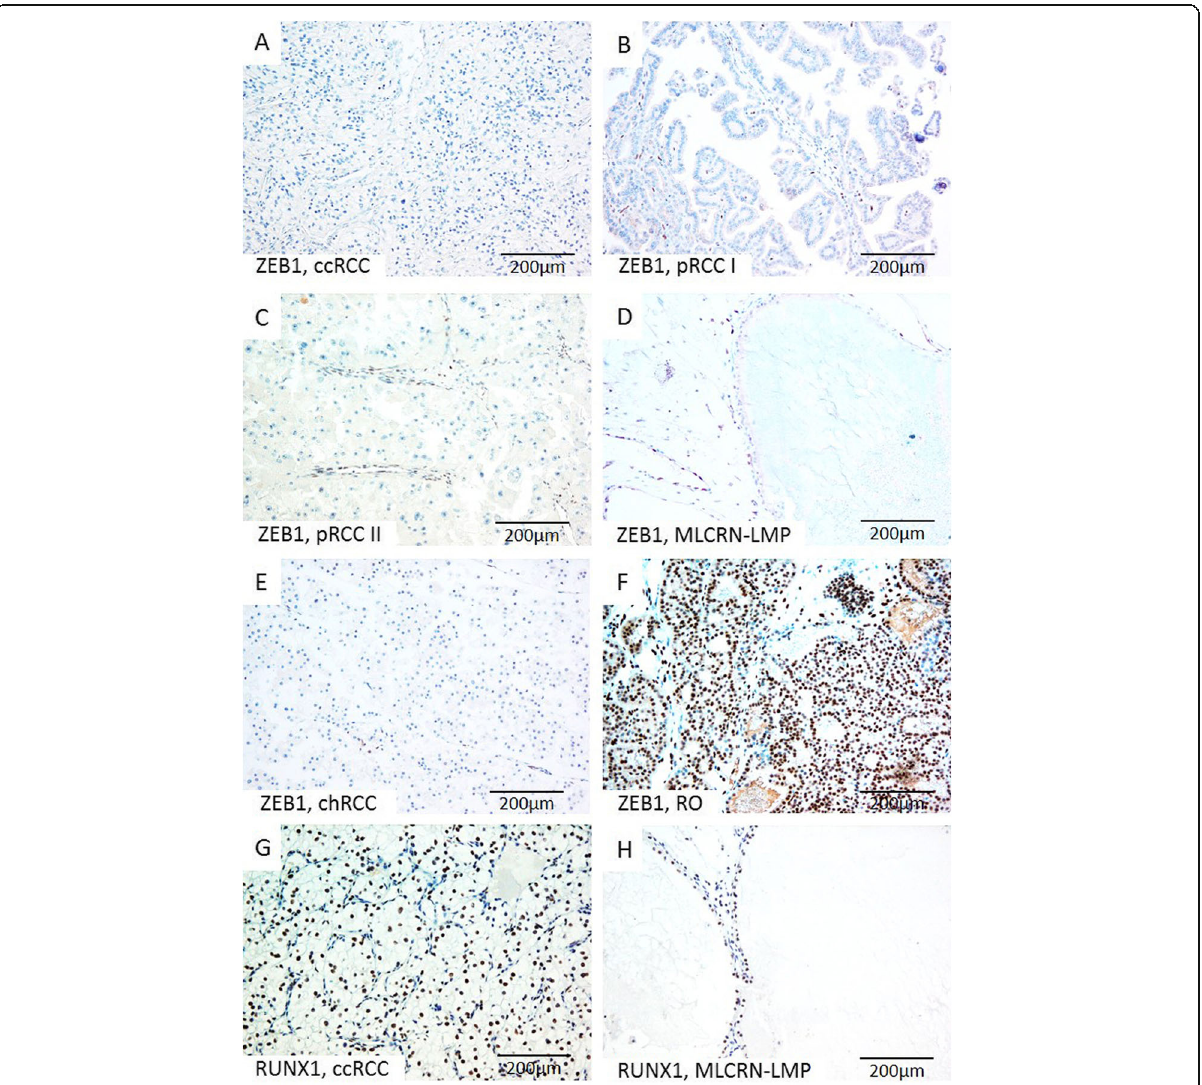
Fig. 2 Representative microscopic photographs of ZEB1 ( a - f ) and RUNX1 ( g - h ) expression in various RCT. ( a - f ) Absence of ZEB1 on tumor cells, but positive nuclear staining on tumor blood vessels in ccRCC, pRCC type I, pRCC type II, MLCRN-LMP and chRCC, ( f ) in contrast to strong diffuse nuclear expression of ZEB1 on tumor cells in RO; ( g - h ) Strong and diffuse nuclear RUNX1 expression on tumor cells immunopositivity in ccRCC and MLCRN-LMP, respectively. Original magnification, ×